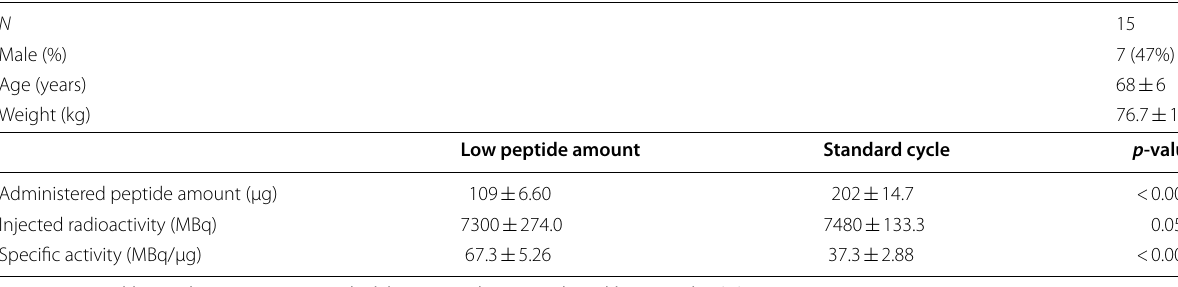
Continuous variables are shown as mean